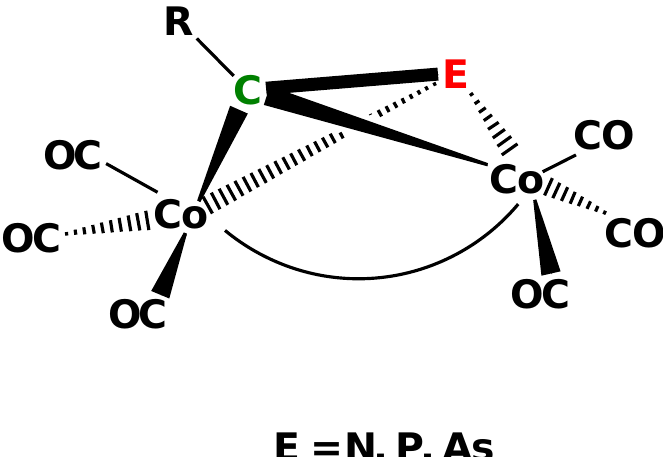
Figure 11. Schematic view of the structures of complexes 16 (E = P), 17 (E = As) [46–49] and of the related hypothetic E = N [50–52] derivative.